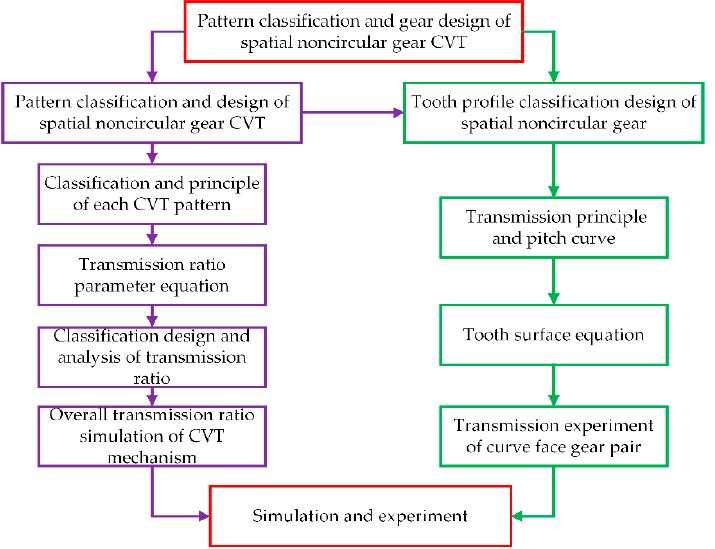
Figure 1. Research workflow of spatial noncircular gear CVT.